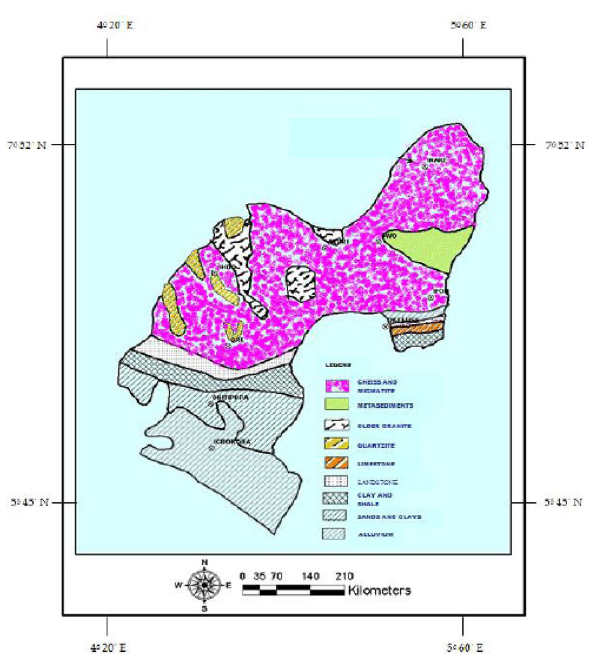
Fig. 2 Geologic map of Ondo State (after Temitope and Opeyemi 2012)